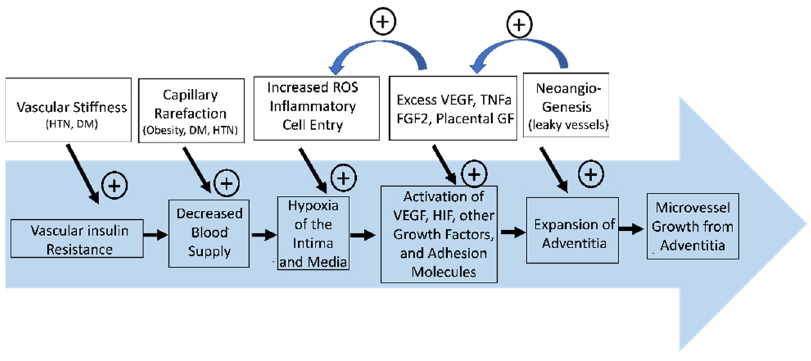
Figure 2. Vascular insulin resistance from metabolic disease such as hypertension and diabetes causes thickening of the intimal layer of the vasa vasorum. This (along with capillary rarefaction) leads to a decrease in blood flow feeding the arterial wall and relative hypoxia of the intimal and medial layers. This activates VEGF, HIF1, HIF2, TNFa, fibroblast growth factor 2, placental growth factor, and adhesion molecules and initiates a positive feedback loop that promotes more hypoxia as these inflammatory molecules increase ROS. This leads to expansion of the adventitia and promotes neoangengiogensis and further vessel injury.